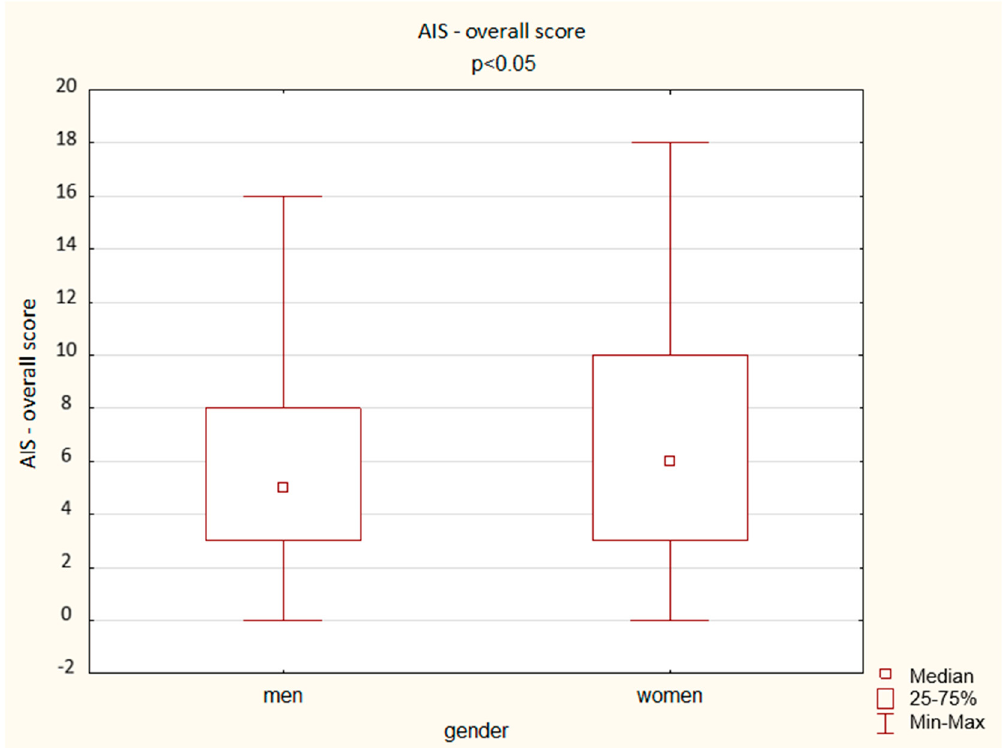
Figure 10. Hospitalized patient results in the AIS—overall score (Mann–Whitney U test).